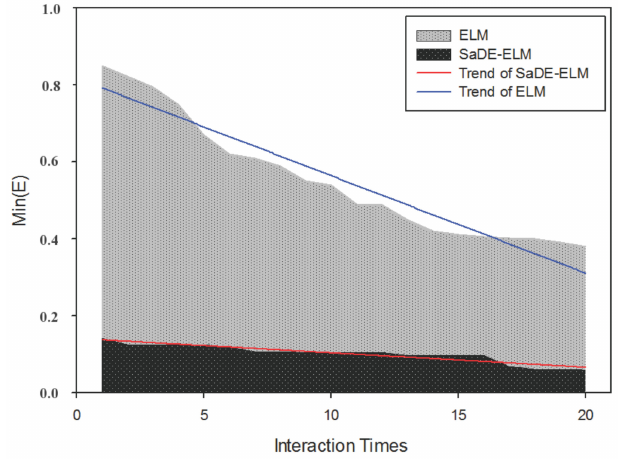
Figure 10. Comparison of the convergence effect of the algorithm.